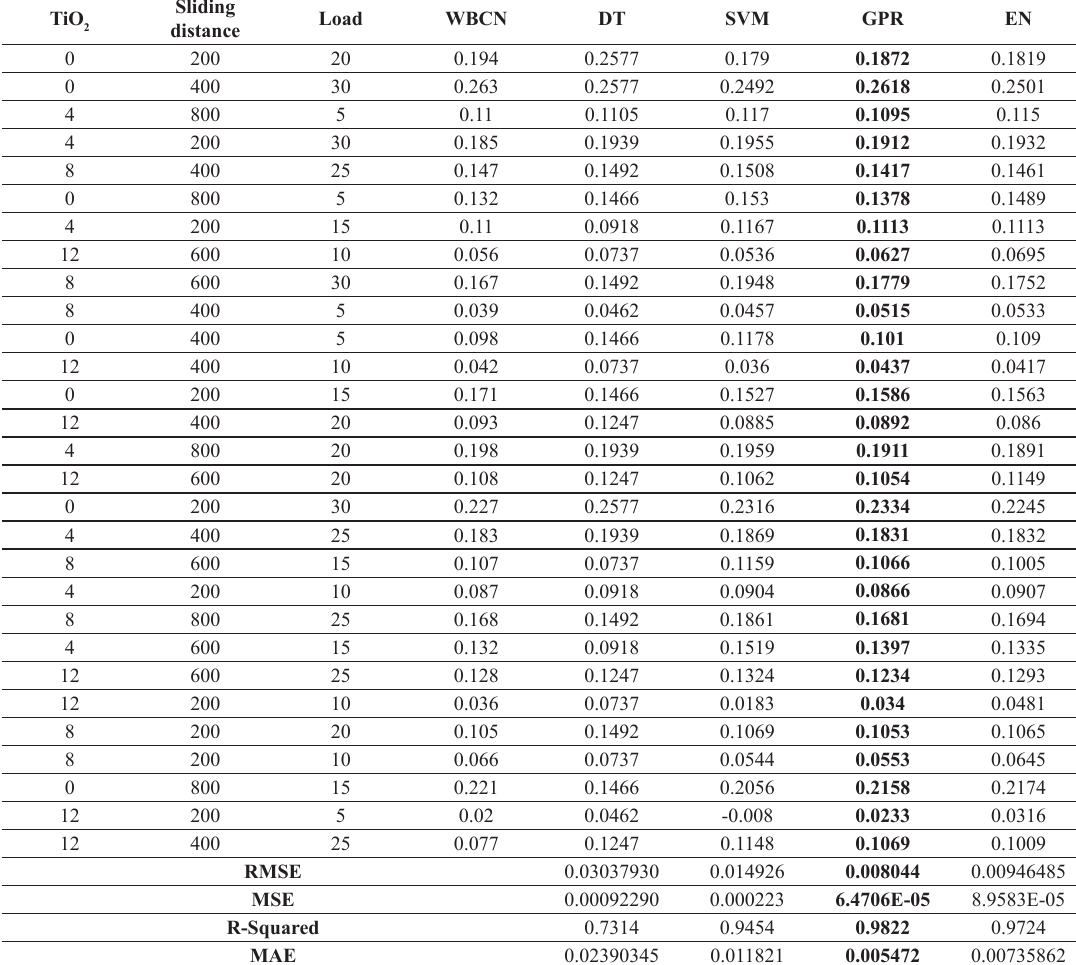
Table 4. Predicting results of the OMLR methods with the 29 testing dataset samples. Sliding TiO distance 2